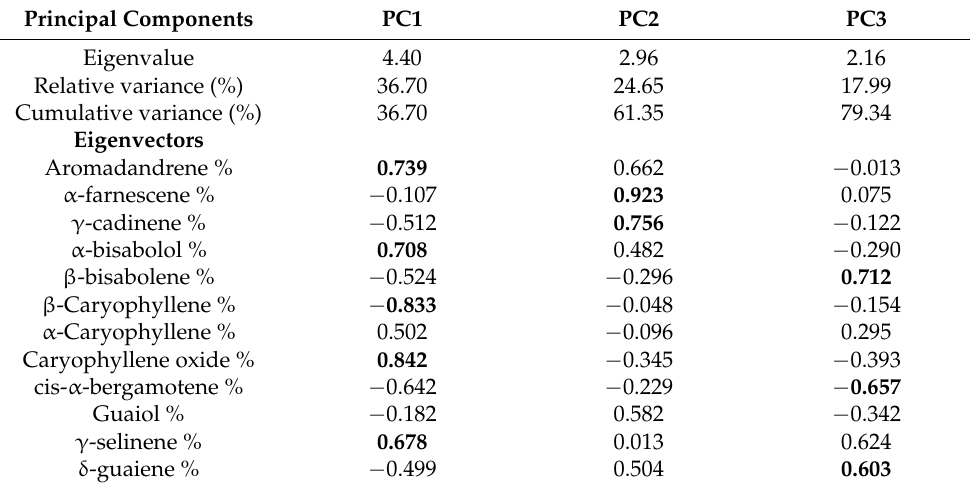
Table 4. Eigenvalues, the relative and cumulative percentage of the total variance, and correlation coefficient for sesquiterpenes compositions of the essential oils extracted with respect to the three principal components (PC1, PC2, and